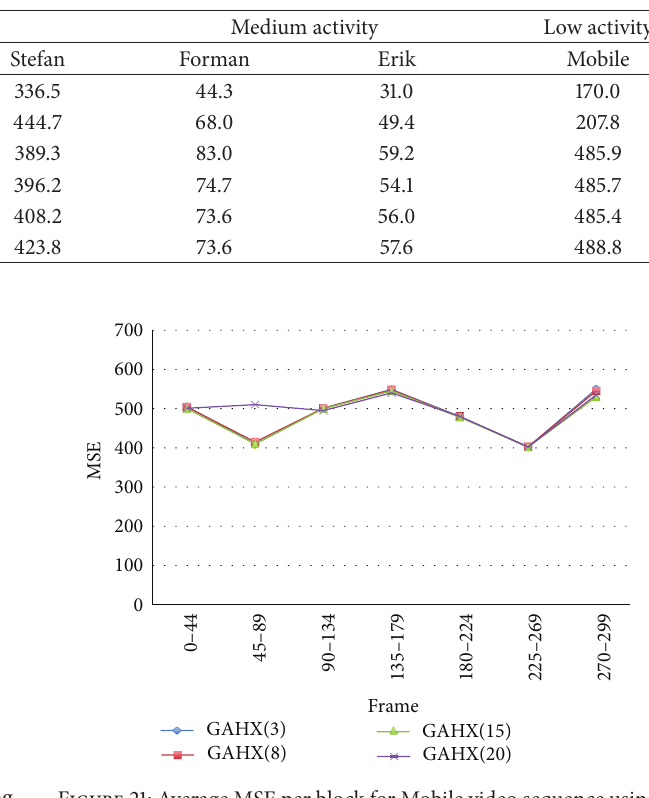
Figure 21: Average MSE per block for Mobile video sequence using various generations with the proposed